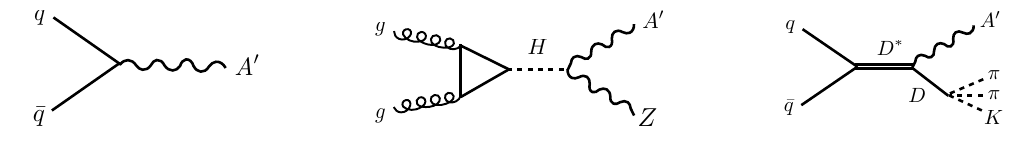
Figure 6 . Diagrams for the production of hidden photons at hadron colliders. Drell-Yan produc- tion (left), Higgs decays (center) and excited meson decays